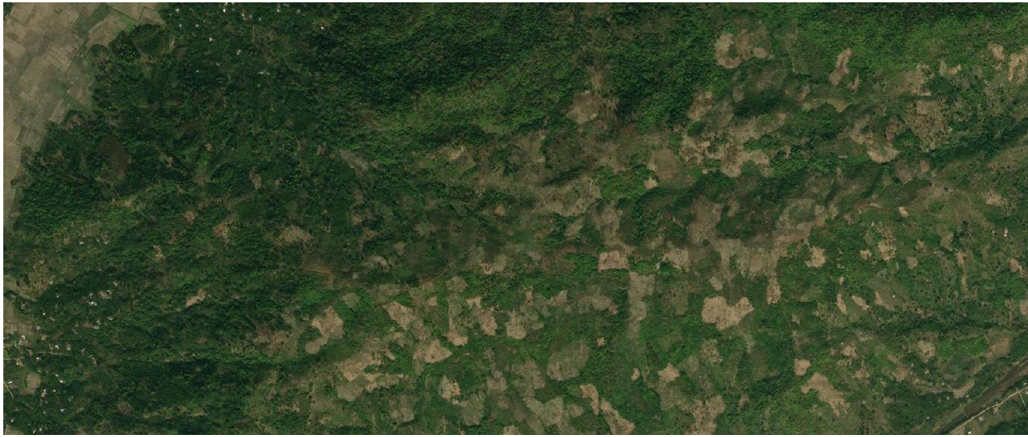
Fig. 10 Aeriel view of the highly erodible barren land on the Bandaraja Hill in the Kulsi basin. Source: Esri, Maxer, Earthstar Geographics, and the GIS